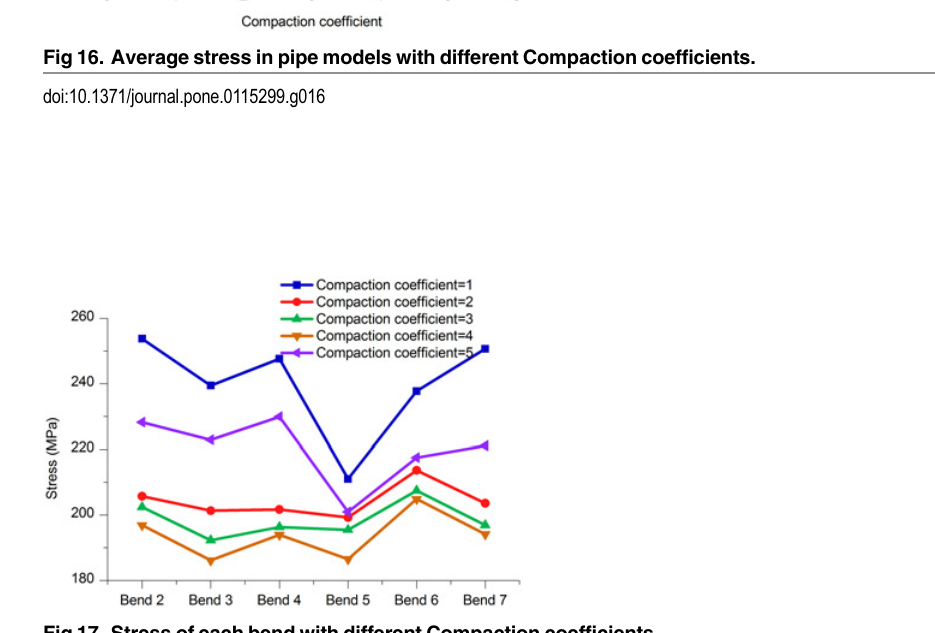
Fig 17. Stress of each bend with different Compaction coefficients.